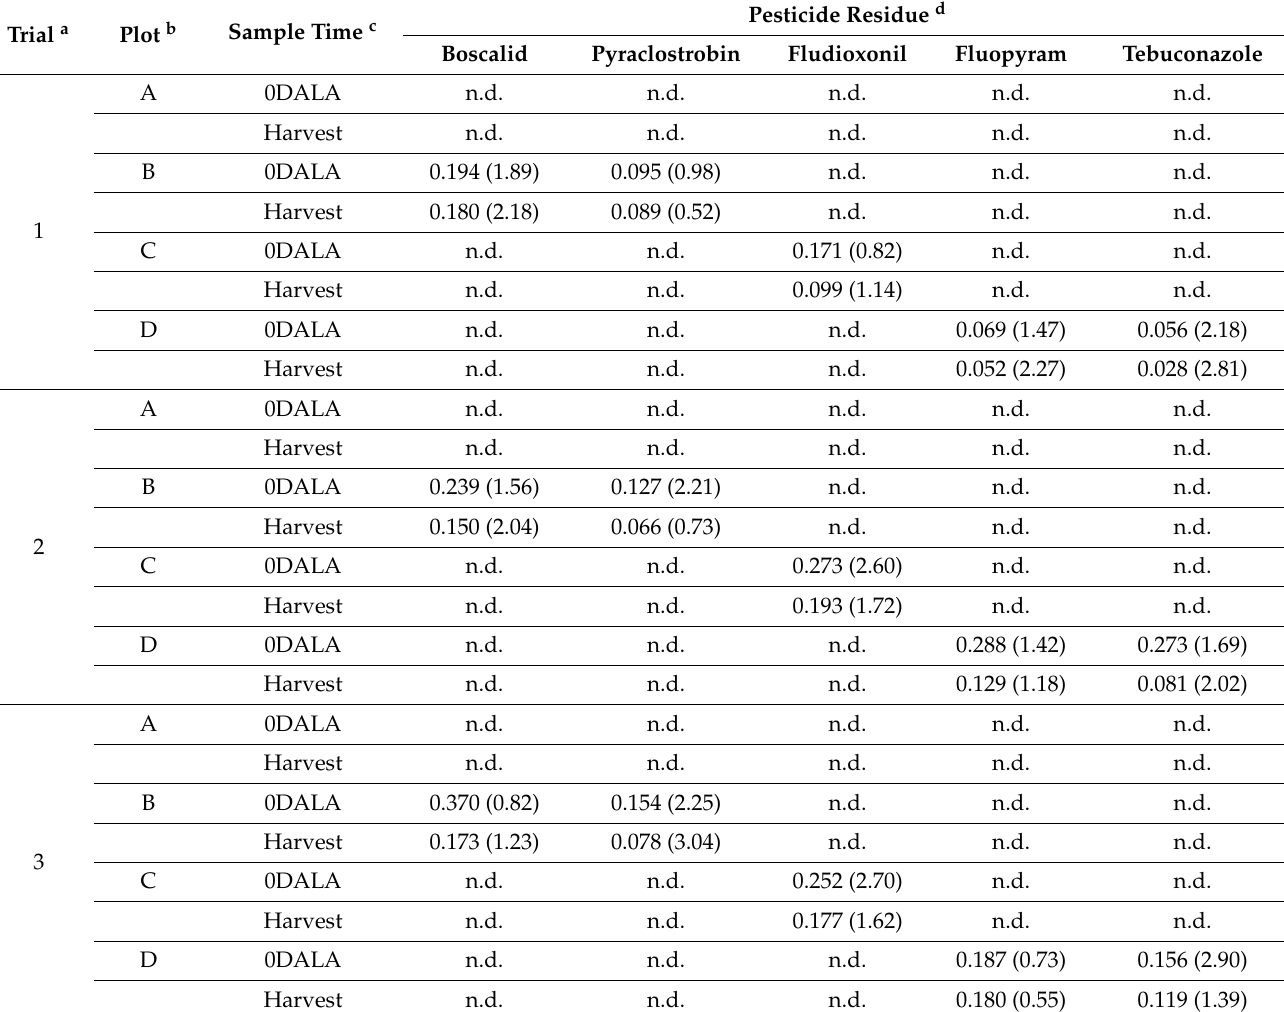
Table 5. Mean concentrations (mg/kg) and relative standard deviation (%) of the target pesticides analyzed in persimmon